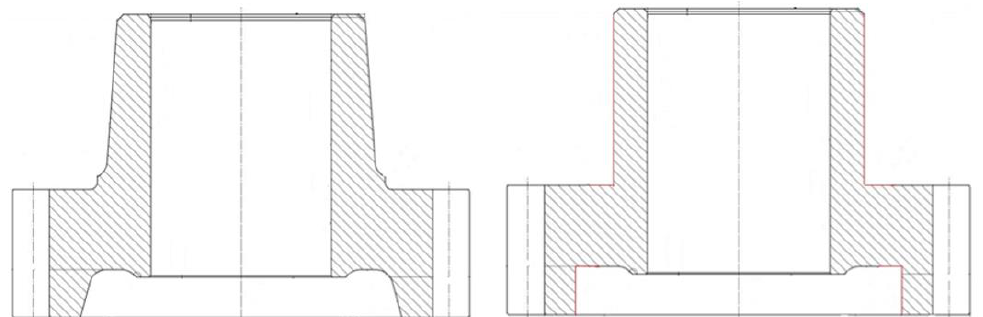
Figure 1. Original counter gear ( left ) and simplified basic geometry ( right ).